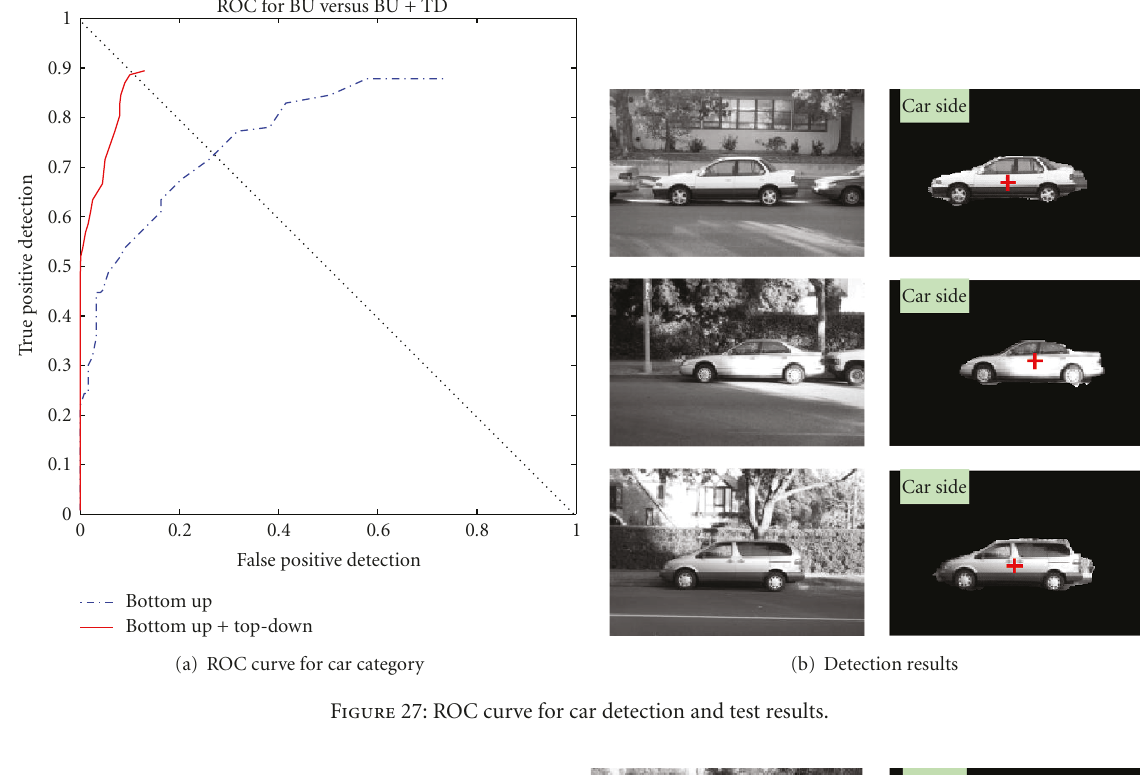
Figure 27: ROC curve for car detection and test results.